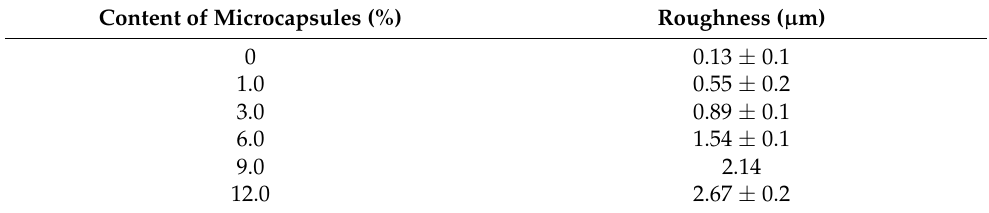
Table 16. Roughness of the paint